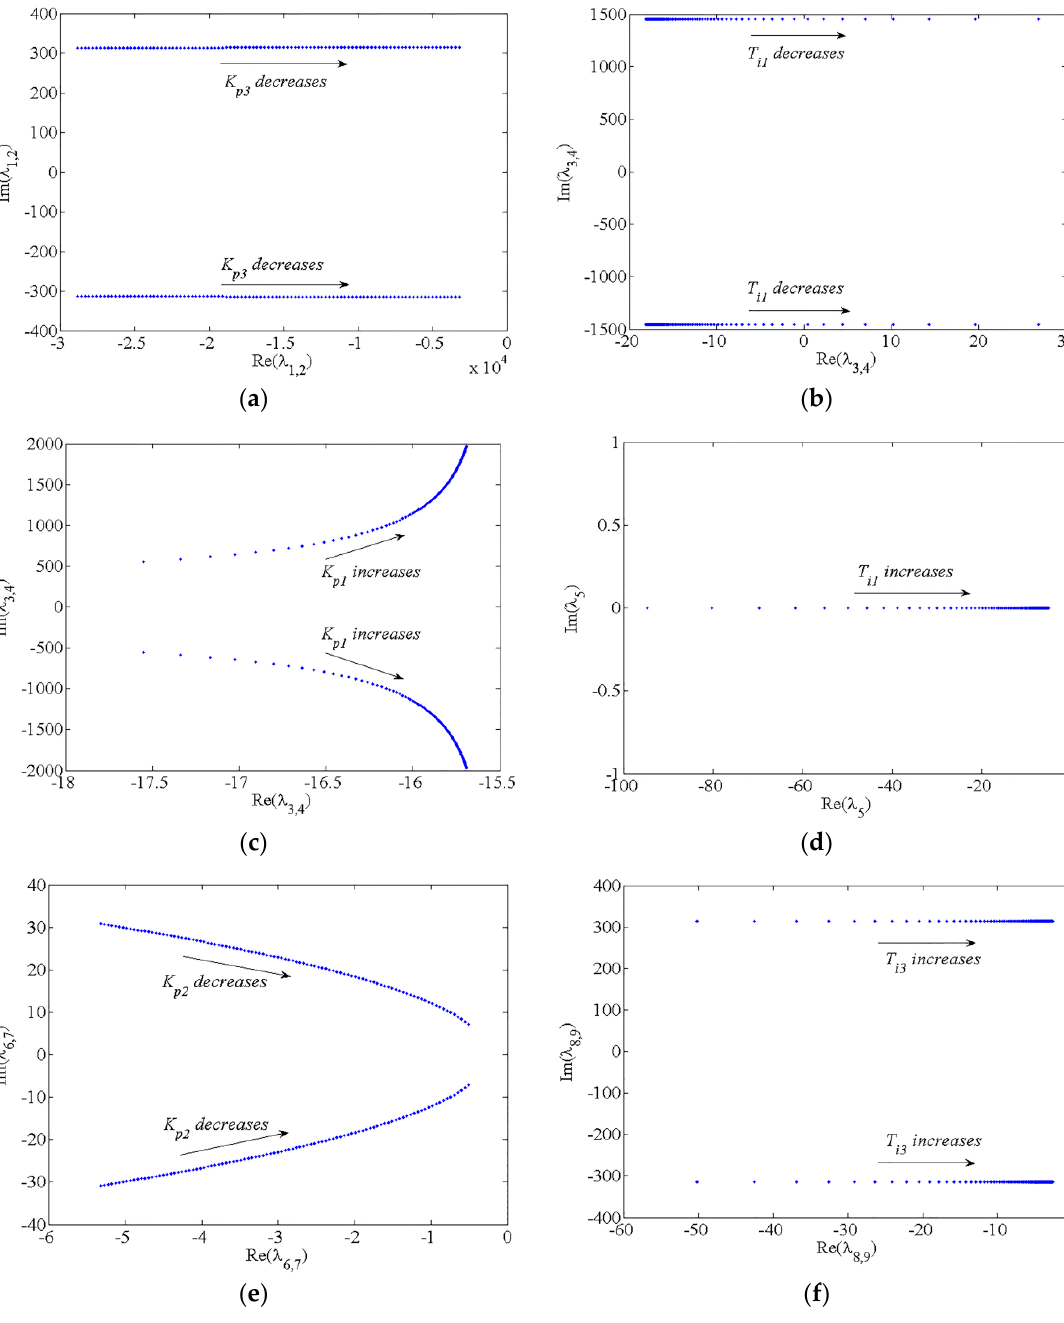
Figure 4. Loci of the eigenvalues with respect to various PI controller parameters: ( a ) λ 1,2 when K p 3 is varied within the range (0.2, 1.8); ( b ) λ 3,4 when T i 1 is varied within the range (0.01, 0.19); ( c ) λ 3,4 when K p 1 is varied within the range (0.005, 0.095); ( d ) λ 5 when T i 1 is varied within the range (0.01, 0.19); ( e ) λ 6,7 when K p 2 is varied within the range (0.002, 0.038); ( f ) λ 8,9 when T i 3 is varied within the range (0.02, 0.38).